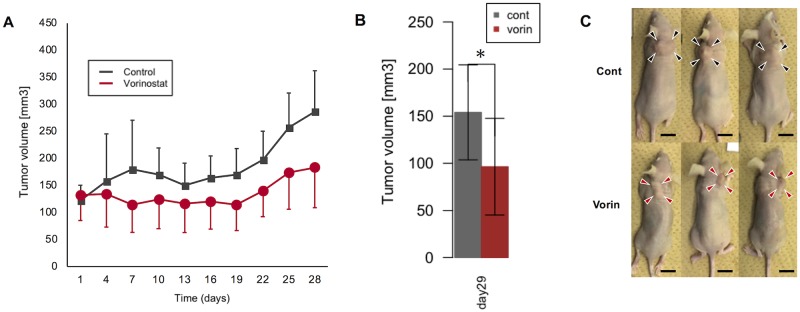
The effect of vorinostat in cUC xenograft model.Changes in tumor volume (A, p = NS by ANOVA, control vs. vorinostat), tumor volume after harvested on day 29 (B, *p < 0.05 by student-t test, control vs. vorinostat) and the representative macroscopic appearance of xenografted mice on day 29. (C, scale bar = 1 cm).